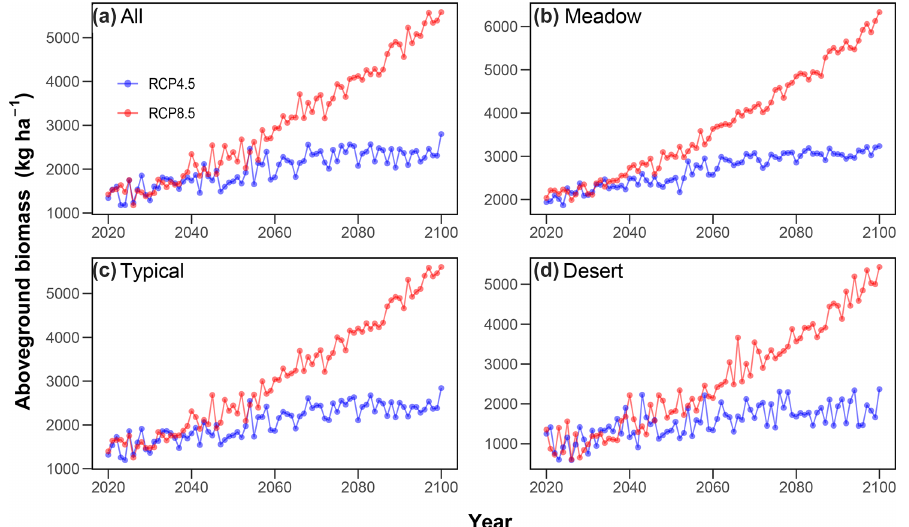
Figure 8. Estimated future aboveground biomass (AGB) in Inner Mongolian grasslands when the CO 2 enrichment effects on AGB are considered. The temporal changes in AGB of all Inner Mongolian grasslands (a) , meadow (b) , typical (c) and desert (d) steppe are